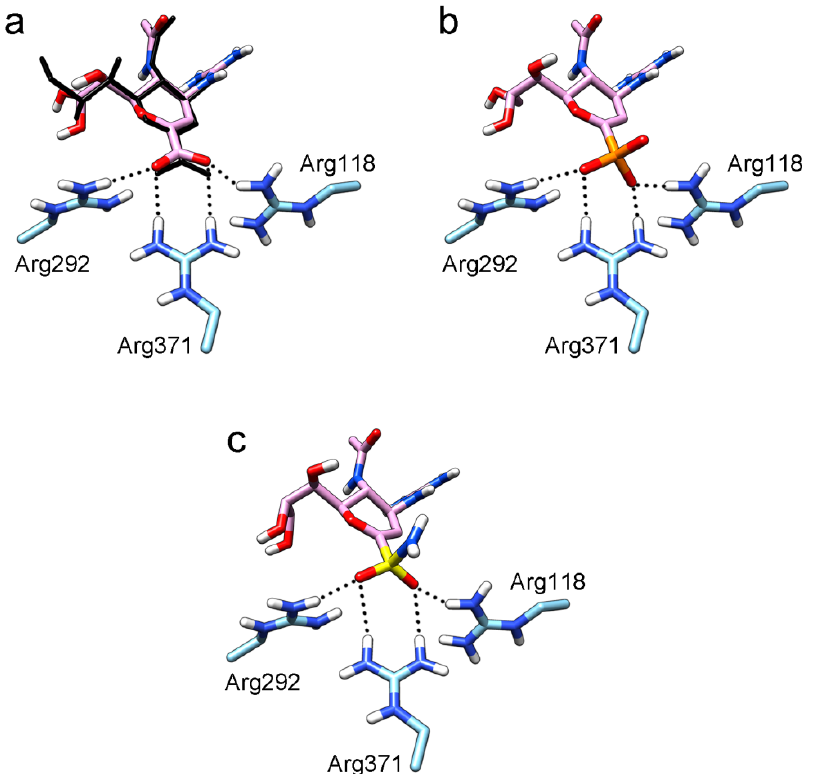
Figure 3. Modeling the interaction of various functional groups of inhibitors with the residues of the arginine triad. ( a ) Zanamivir, ( b ) phosphonic analogue of zanamivir, and ( c ) sulfonamide analogue of zanamivir. The coordinates of zanamivir taken from the available crystal structure 3b7e are shown in black.